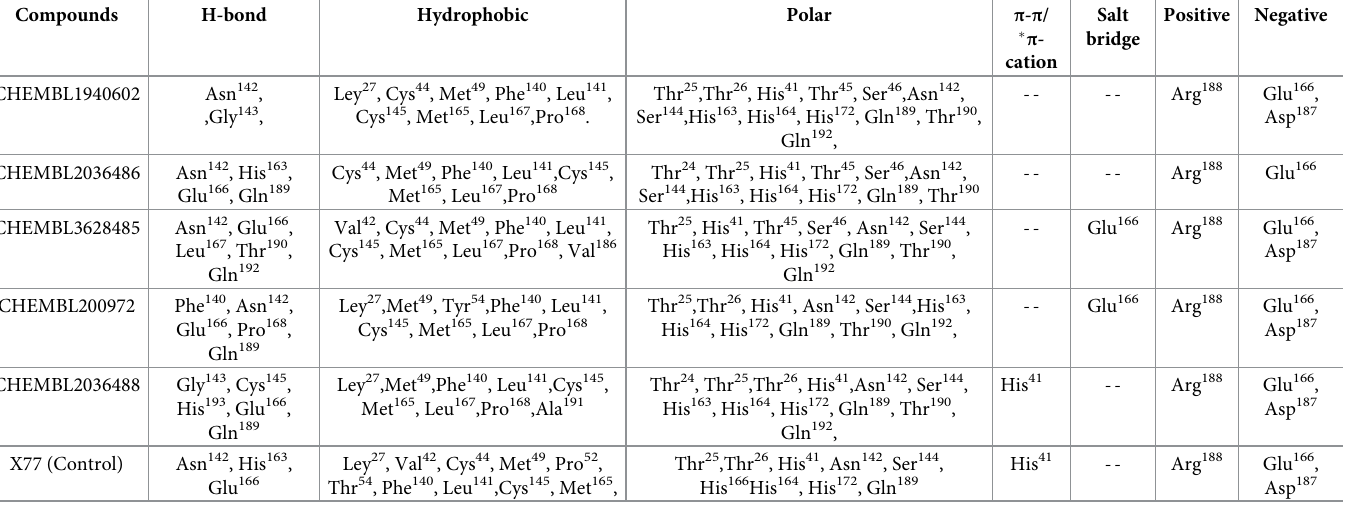
Table 1. Intermolecular interactions noted for the screened compounds with the SARS-CoV-2 M pro within 4 Å around the docked ligand in the respective binding pockets. Compounds